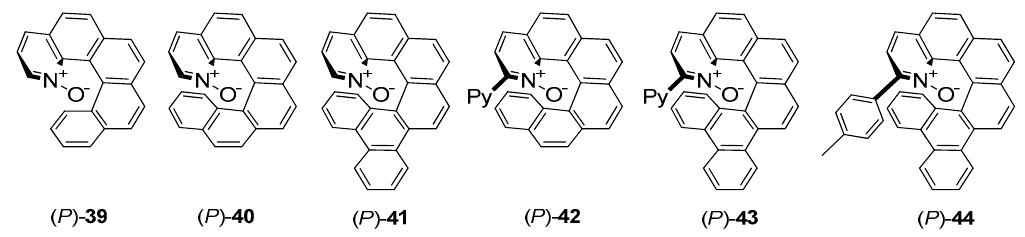
Figure 8. Helically chiral N -oxides.